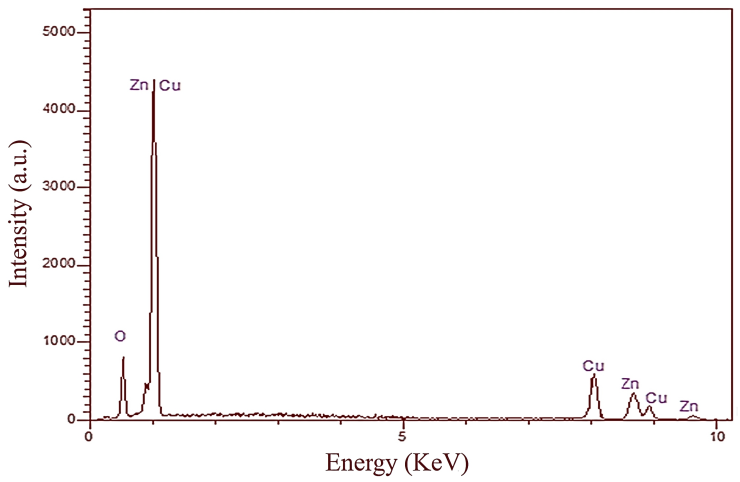
Figure 3. EDS spectrum of the flower-like CuO-ZnO hybrid hierarchical nanostructures grown on copper substrate.